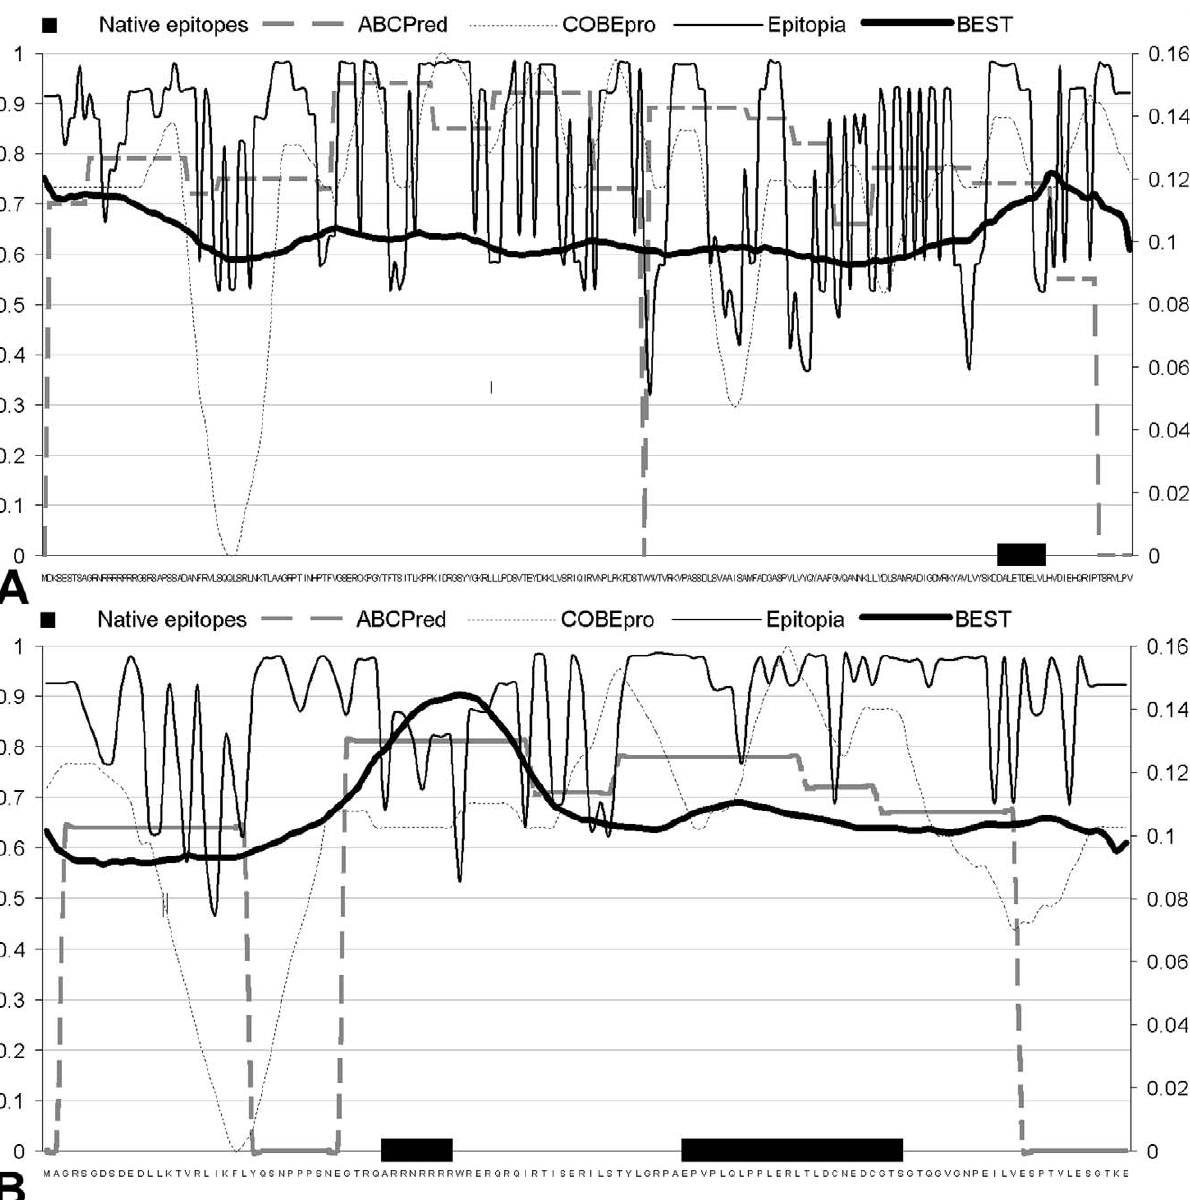
Figure 8. Residue epitopic propensities predicted by ABCPred, COBEpro, Epitopia and BEST for a capsid protein (UniProt ID: P16489; panel A) and an anti-repression transactivator protein (UniProt ID: P20869; panel B). The plots also include the location of the native epitopes. The x -axis shows the protein chain and the location of the native epitopes (denoted with black horizontal line) and y -axis shows the values of the predicted propensities. The left y -axis gives the propensities for ABCpred, COBEpro and Epitopis and the right y -axis for